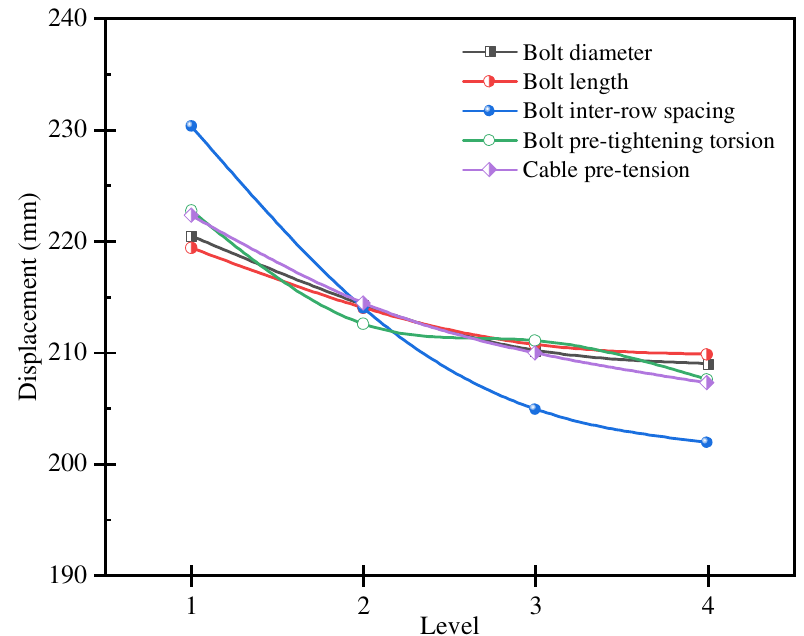
Figure 15. Sensitivity characteristics of each influencing factor in the deformation of roadway’s sur-